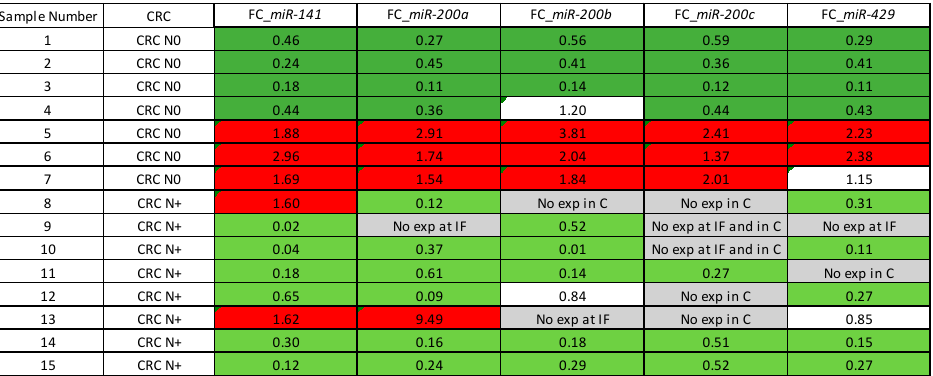
Figure 6. Expression of the miR-200 family and their target genes in CRC N0 ( n = 13) in comparison with CRC N+ ( n = 17): ( a ) expression of the miR-200 family; ( b ) expression of miR-200 family target Legend: CRC, colorectal carcinoma; ∆∆ Cq, delta quantitation cycle; N0, without nodal metastases; N + , genes. Legend: CRC, colorectal carcinoma; ΔΔ Cq, delta quantitation cycle; N0, without nodal with nodal metastases; * p ≤ 0.05; *** p ≤ 0.001. metastases; N+, with nodal metastases; * p ≤ 0.05; *** p ≤ 0.001.